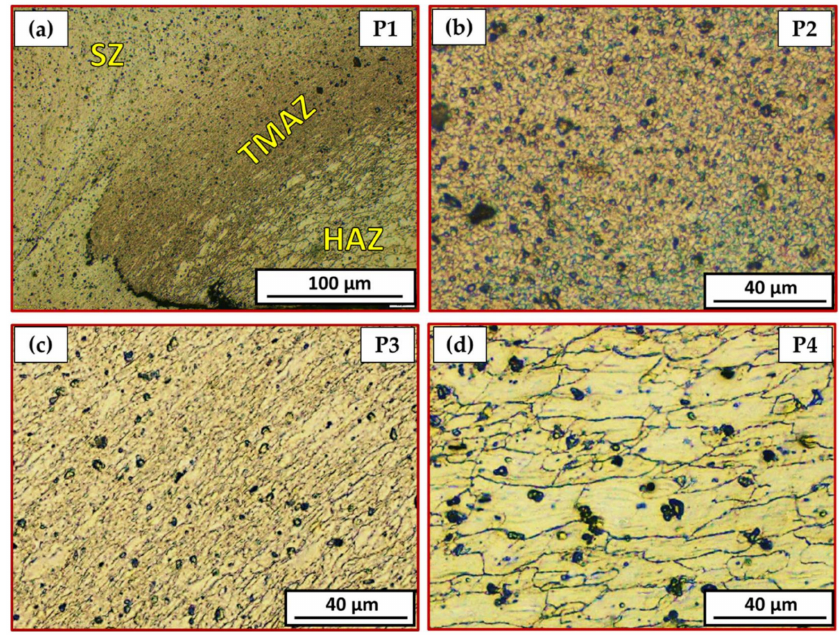
Figure 12. Different microstructure zones of the joint spot welded at 600 rpm where P1 is mixed zone of SZ/TMAZ/HAZ in ( a ), P2 is SZ in ( b ), P3 is TMAZ in ( c ), and P4 is HAZ in ( d